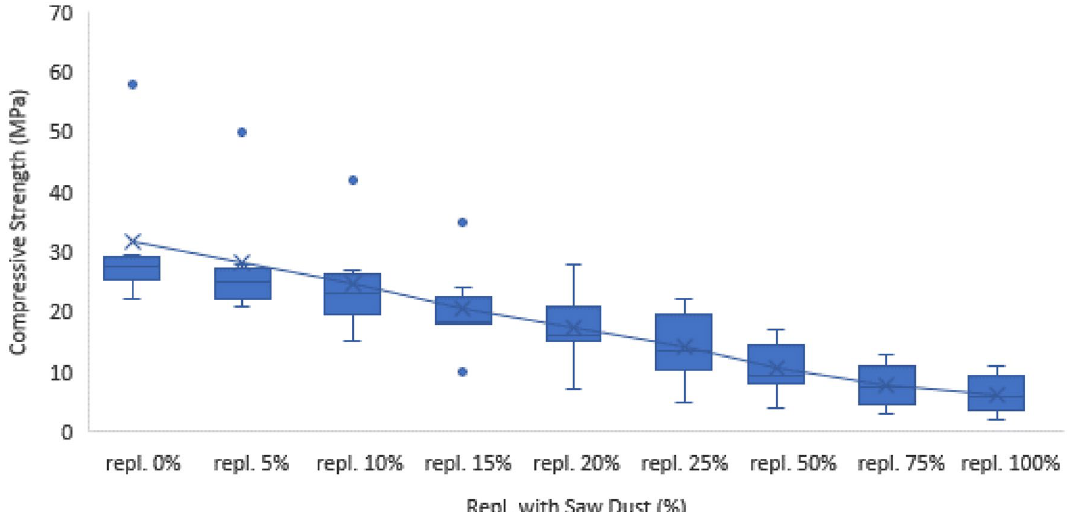
Fig. 5 Compressive strength of sawdust concrete by replacing sand with sawdust [84, 86, 88–90, 94]